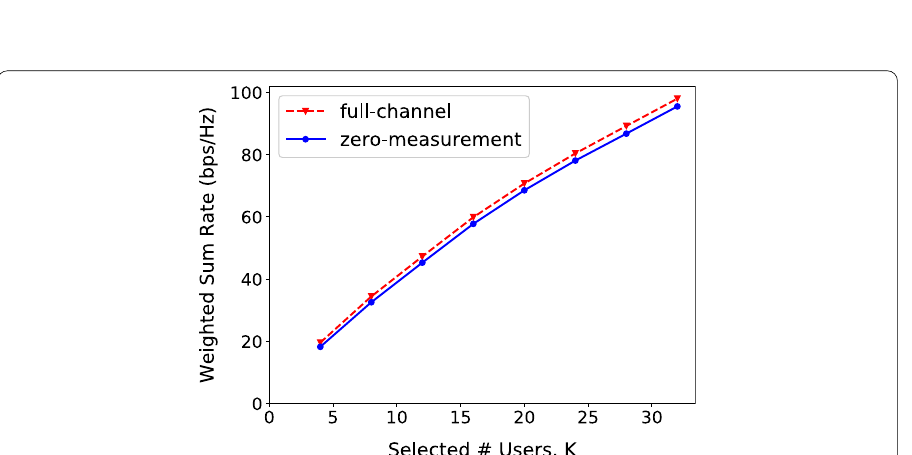
Fig. 10 The weighted sum rate with zero-measurement selection and full-channel selection, respectively. The system setup is that a 64-antenna base-station selects changing number of users out of 100 users for downlink beamforming based on simulated